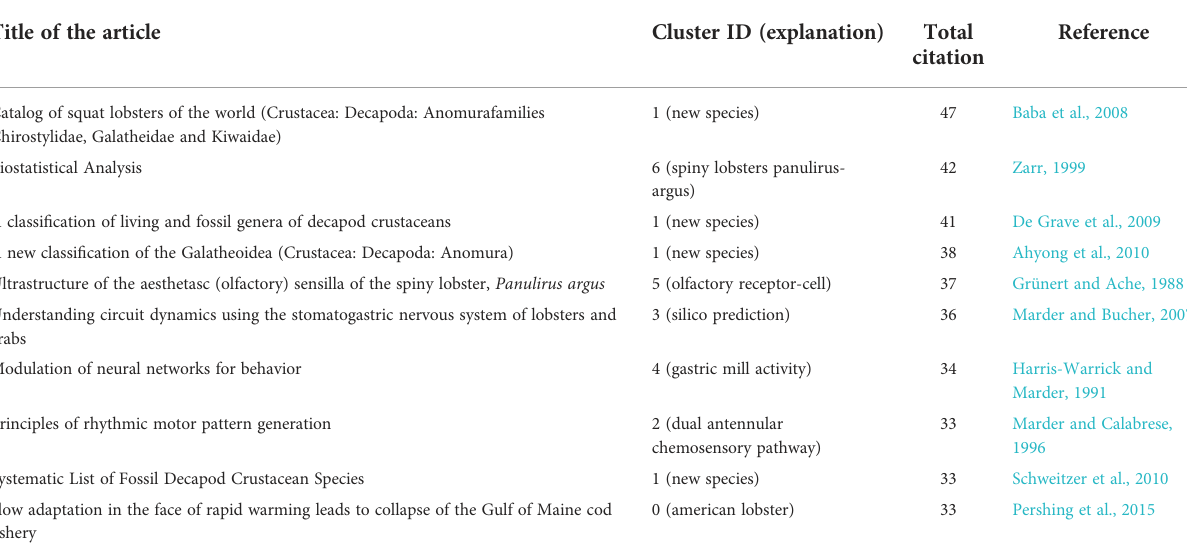
TABLE 4 Top 10 highest-cited articles in the lobster research theme.